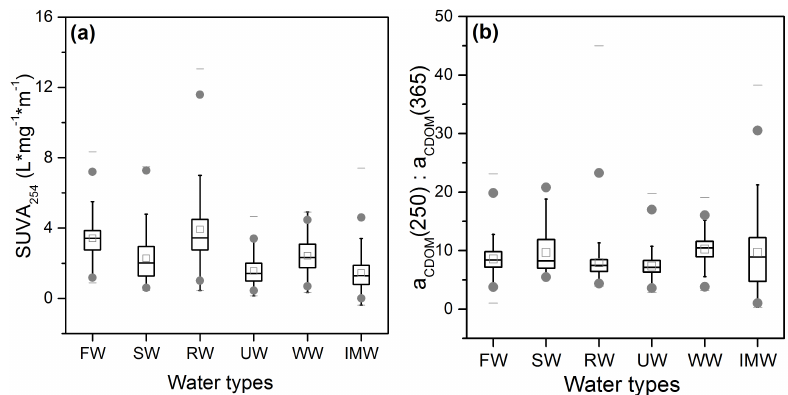
Figure 7. Comparison of (a) SUVA 254 and (b) M values ( a CDOM ( 250 )/a CDOM (365)) to various types of inland waters. FW, fresh lake water; SW, saline lake water; RW, river or stream water; UW, urban water; WW, ice-covered waters from Northeast China; and IMW, ice melt waters from Northeast China.